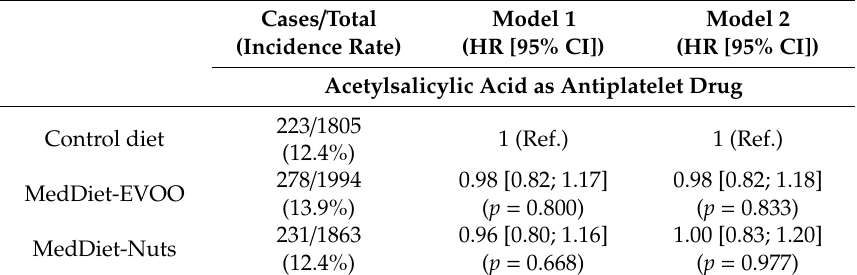
Table 3. Incidence of new users of acetylsalicylic acid as antiplatelet